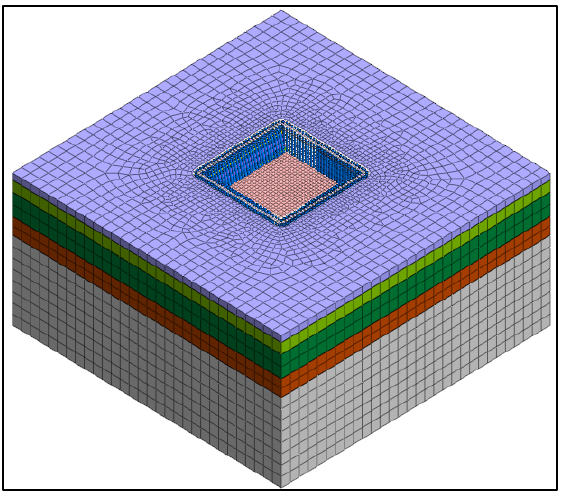
Figure 4. 3D finite element model. Table 1. Structural properties adopted in the numerical analysis.